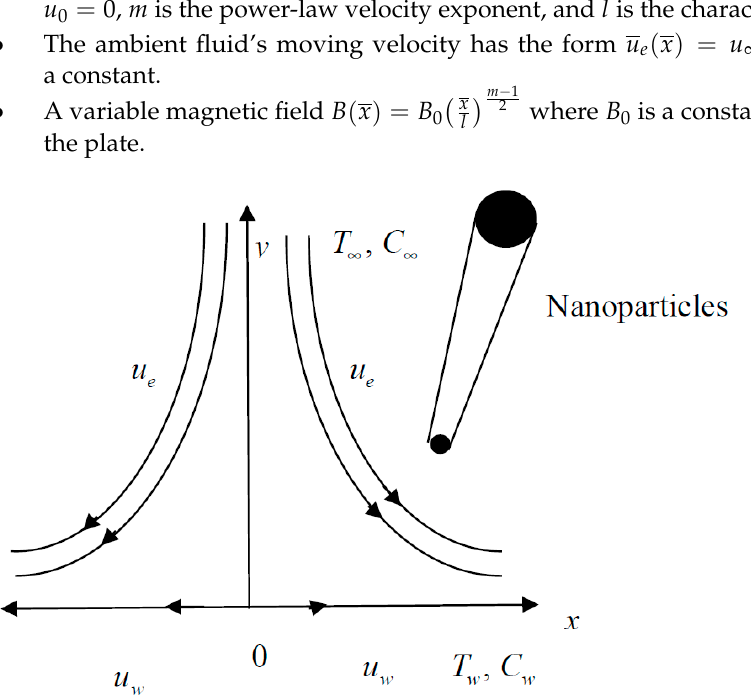
Figure 1. Physical model of the flow.